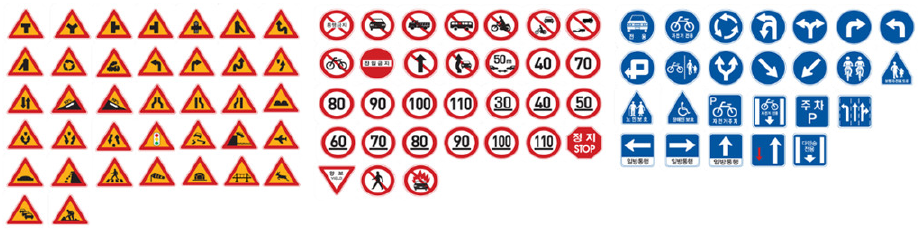
Figure 8. Designed structure to be classified.